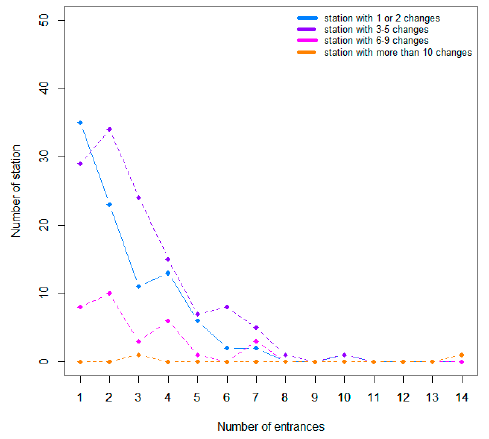
Figure 20. Relationship between the number of subway entrances for each subway stations and the number of changes.